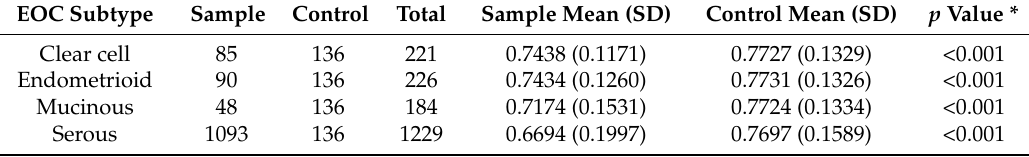
Table 1. Sample numbers and means of the gene set regularity indices for each subtype. The table displayed the sample numbers, means and SDs of GSR indices for the four EOC subtypes and the normal ovarian tissue controls computed through the GO term gene sets. The 136 normal ovarian tissue sample gene expression profiles were utilized as the control group for the all of the four EOC subtypes.